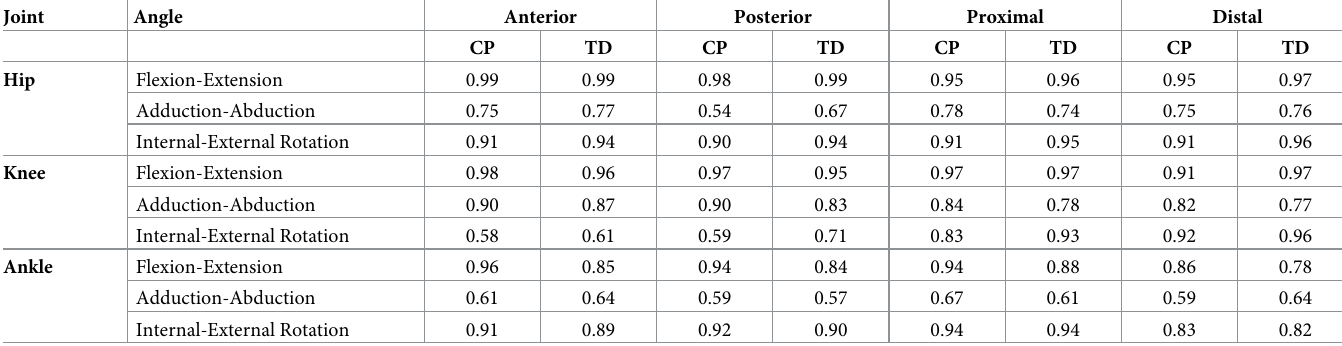
Table 2. Correlation coefficients R between RMSD and magnitude of misplacement in percentage of leg length for both group. Joint Angle Anterior Posterior Proximal